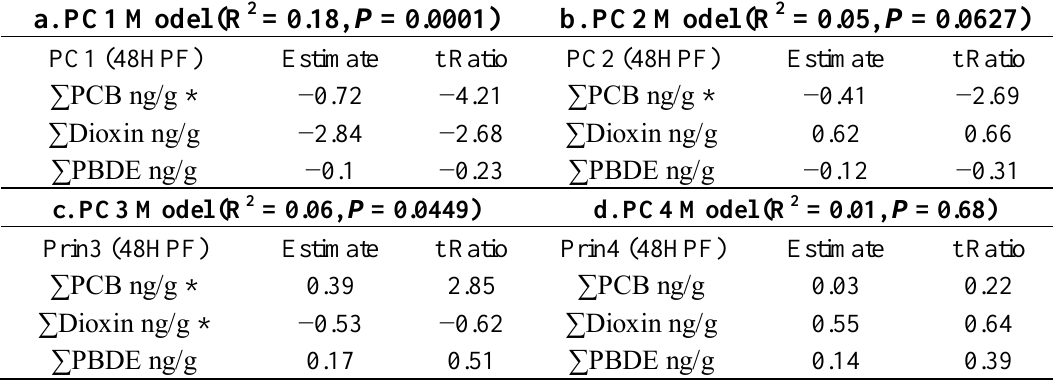
Table 3. Standard least squares multiple linear regression effects for 48 h post-fertilization principle components. Model parameters are ng/g sediment of: Total PBDEs congeners, total PCB congeners, and total Dioxins. All sediment contaminant values were log transformed. T-Ratio is the ratio of the estimate to its standard error.